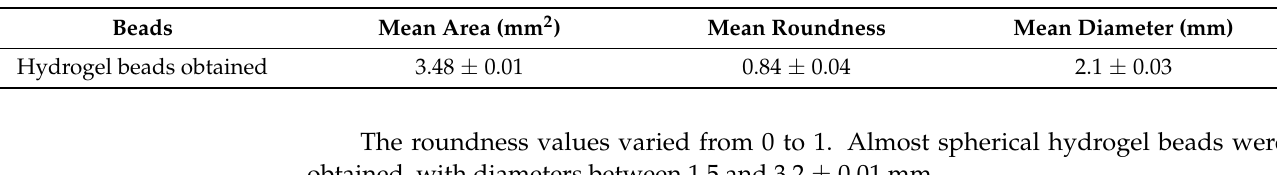
Table 8. Characteristics of hydrogel